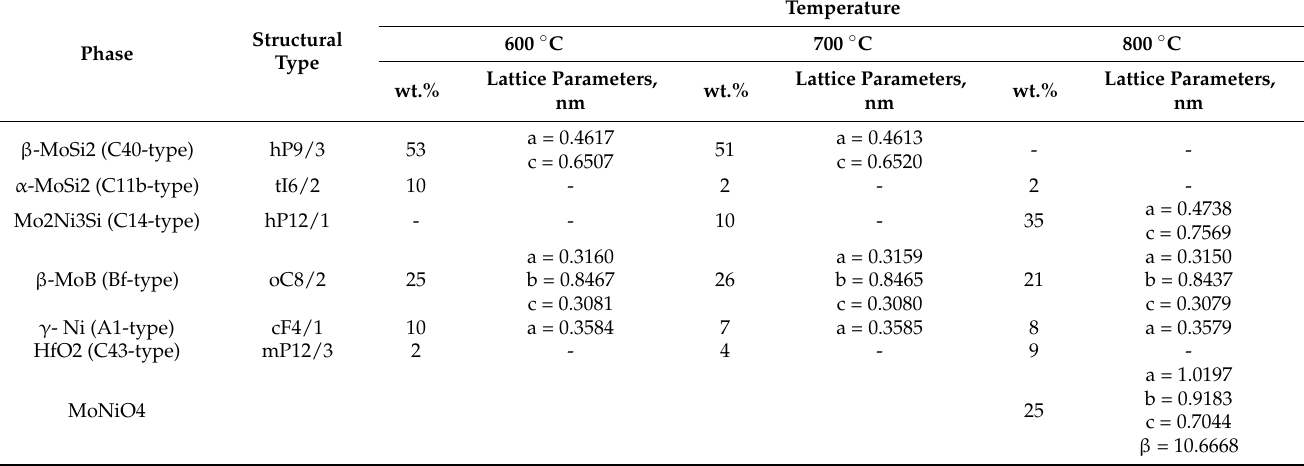
Table 3. Phase composition of the coating after annealing at indicated